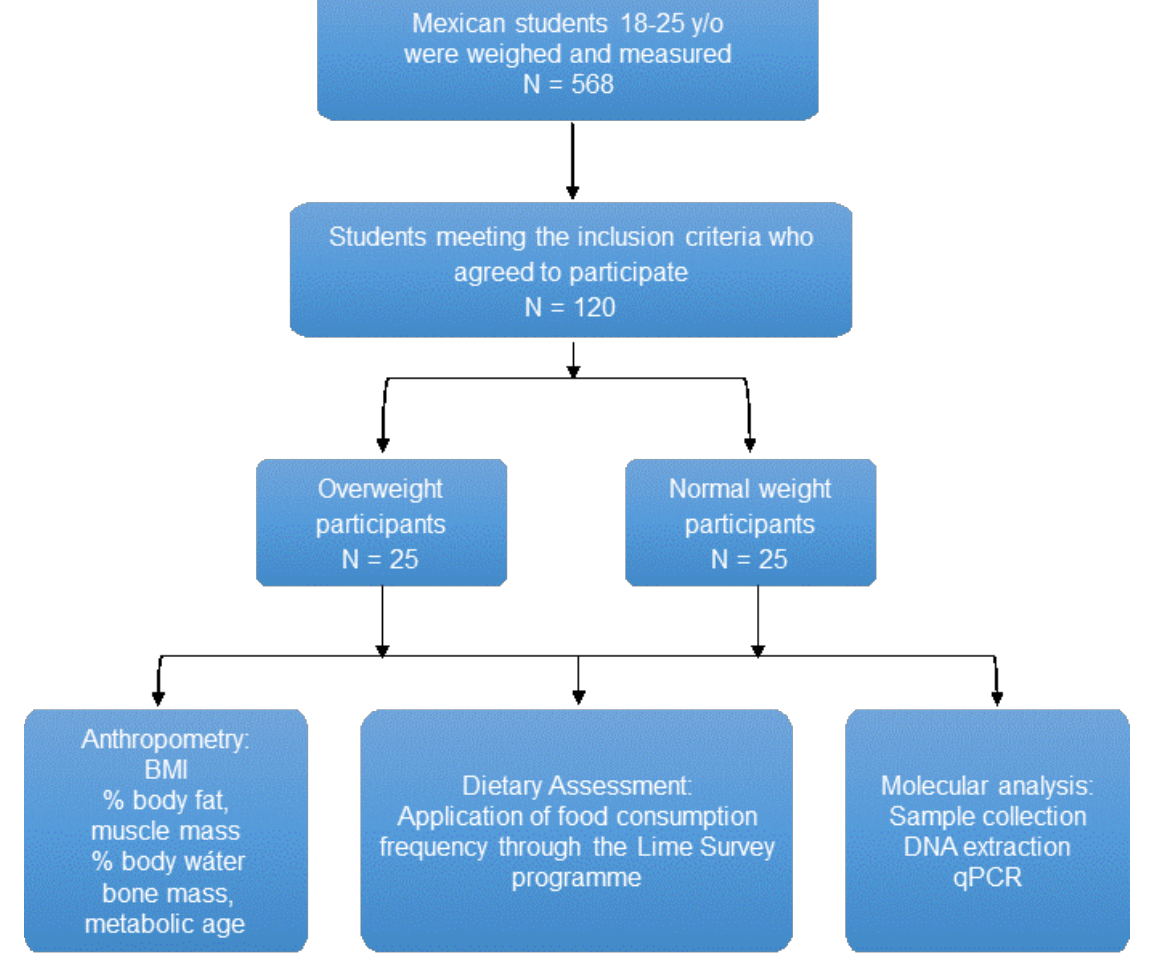
Figure 1. Schematic diagram of the present study. Abbreviations: BMI, body mass index; DNA, deoxyribonucleic acid; qPCR, quantitative polymerase chain reaction; y/o, years old; %, percentage.